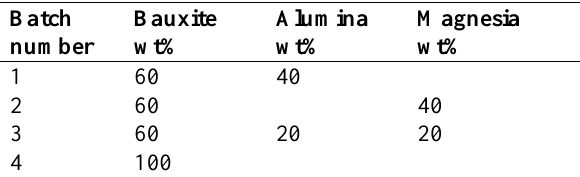
Mixing ratios in weight percentages of starting materials to prepare Bauxite based